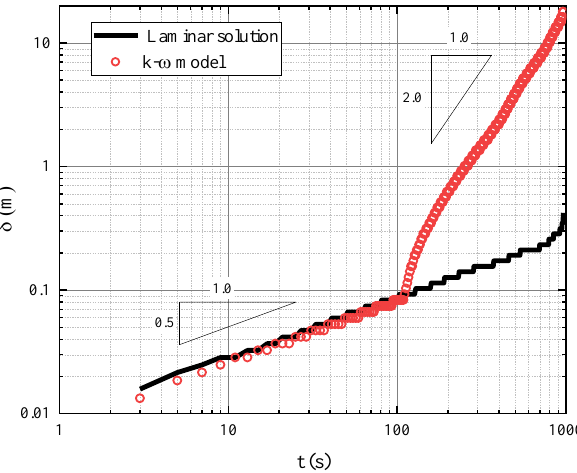
Figure 7. Transitional behavior from laminar flow regime to turbulent flow regime.